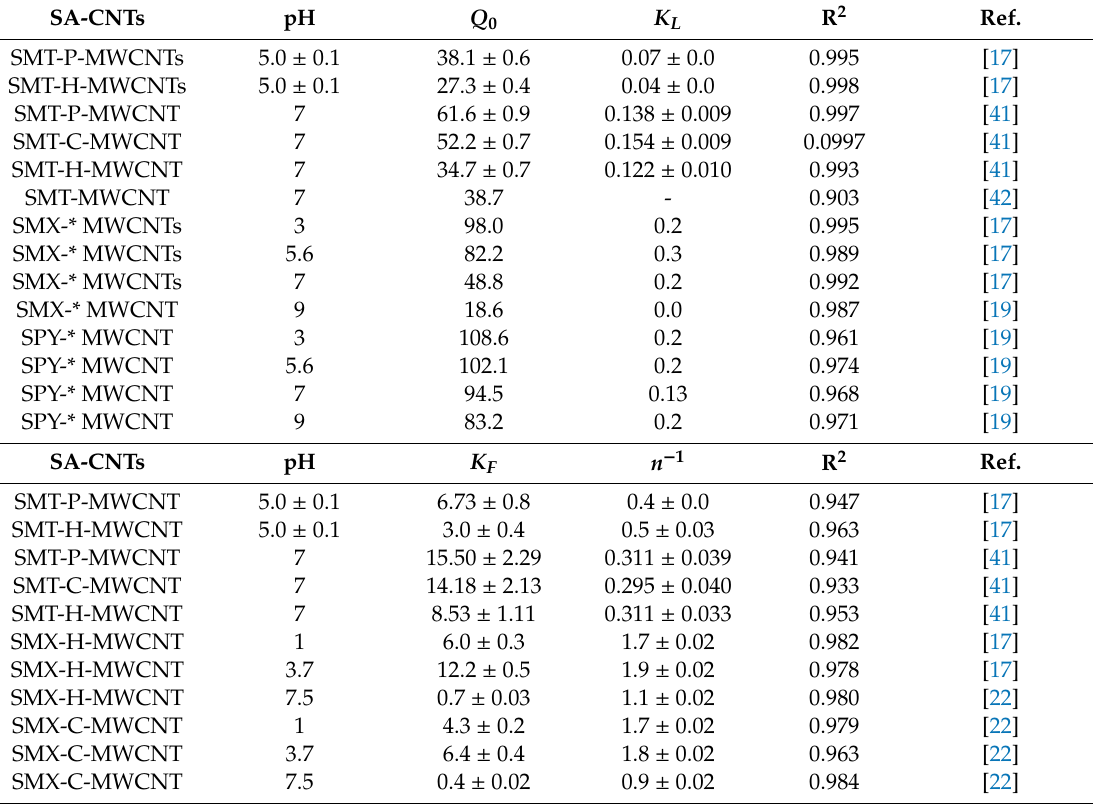
Table 2. Langmuir and Freundlich model fitting adsorption isotherm parameters for adsorption of SMT, sulfapyridine (SPY), and sulfamethoxazole (SMX) by MWCNTs, H-MWCNTs, C-MWCNTs, and pristine-MWCNTs (P-MWCNTs) cited from reference